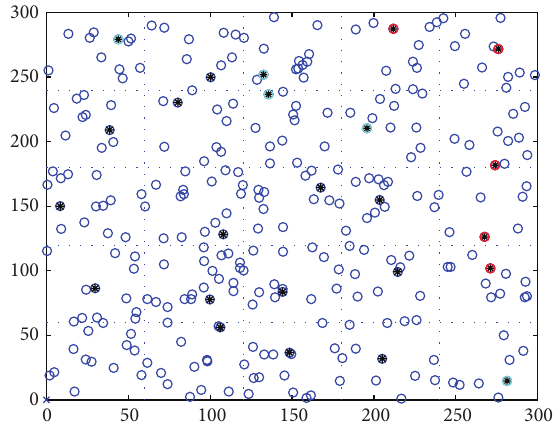
Figure 1: The division of